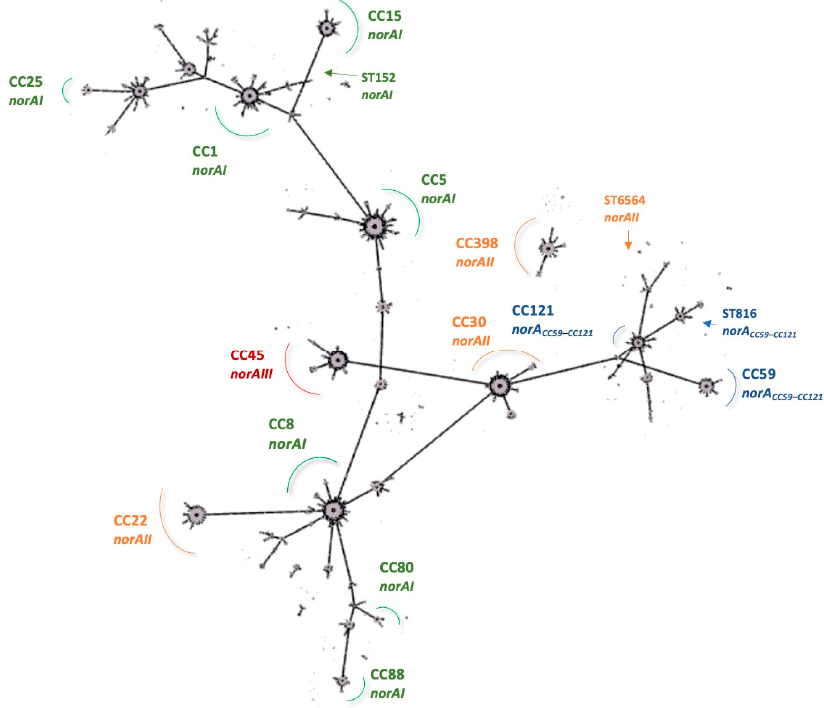
Figure 5. Global distribution of norA alleles amongst the main S. aureus clonal lineages. The maximum spanning tree was constructed using all S. aureus MLST profiles available at PubMLST with the PhyloviZ 2.0 Online software. The clonal lineages differing by up to three loci are linked.